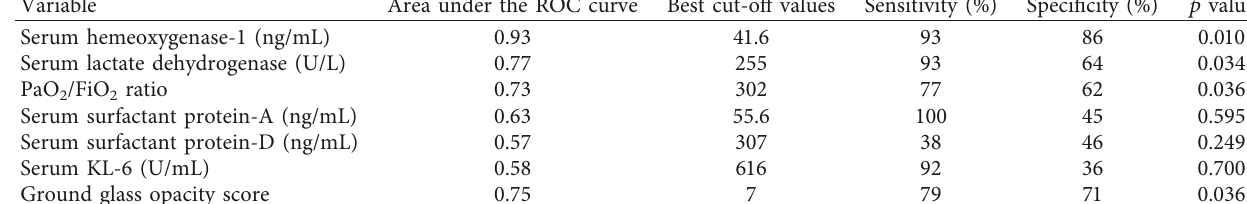
Table 2: The receiver operating characteristic curve for the serum HO-1 level (detecting an AE patient). Variable